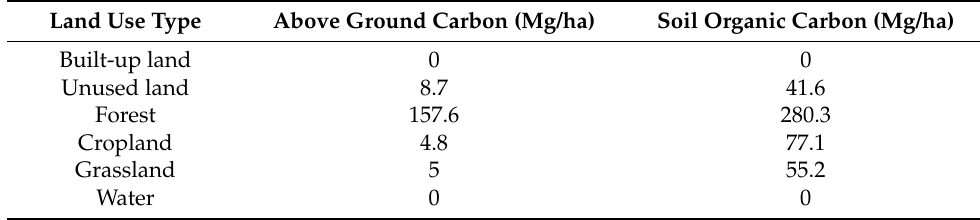
Table 2. Carbon densities of six land use